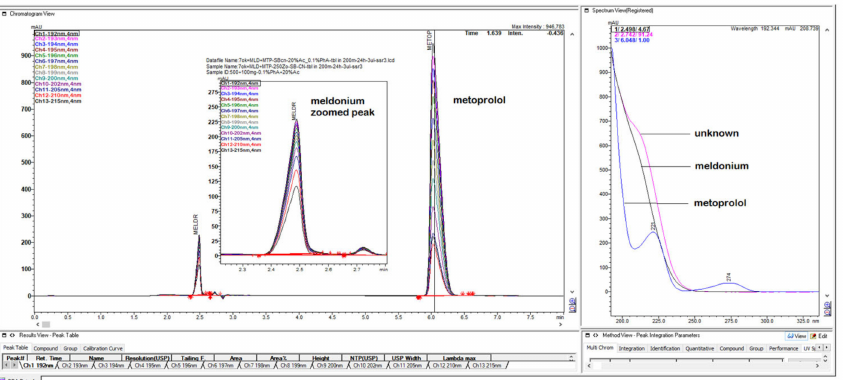
Figure 41. Chromatograms, performed with diluted acids, without use of phosphate salts. The first choice was 0.1% v / v o-H 3 PO 4 80% and 20% ACN, recorded and overlaid at 13-different UV- wavelengths N- 20%ACN-80% 0.1% o-H 3 PO 4 . Distorted peaks with leading of meldonium and tailing of metoprolol were, for the first time, clearly